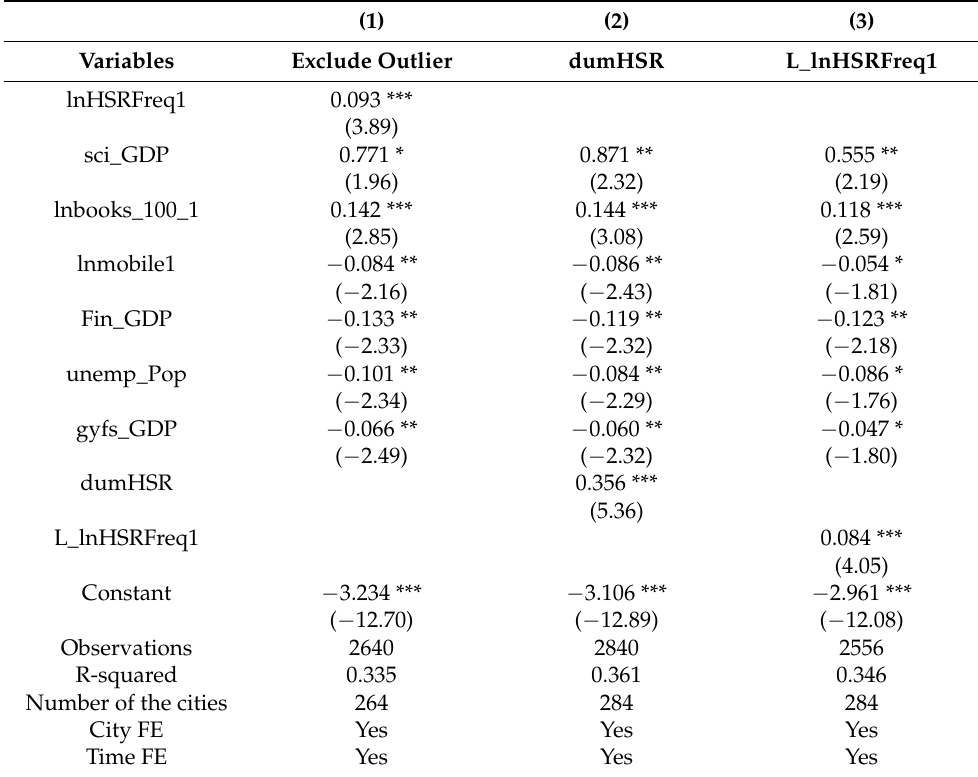
Table 7. The results of the robustness